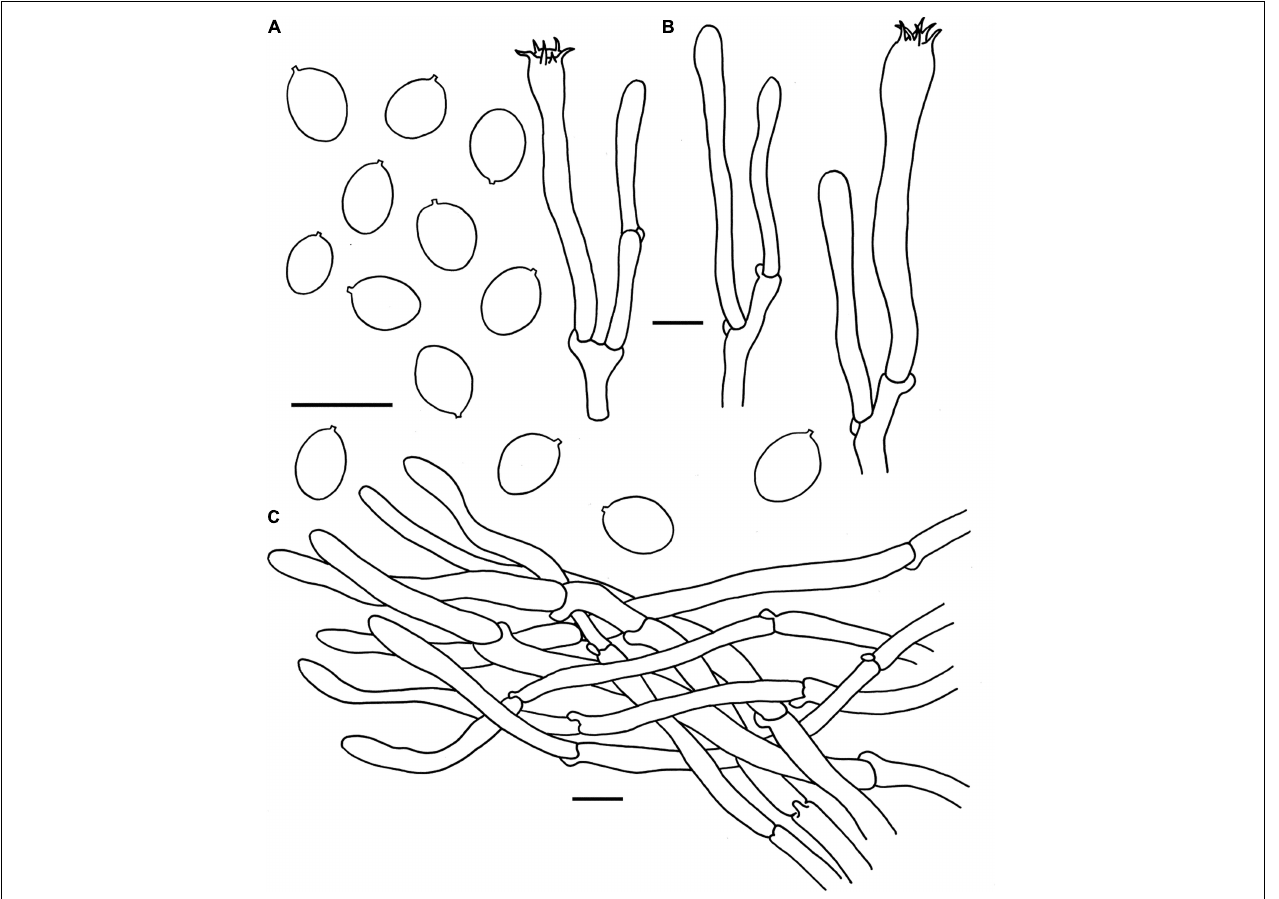
FIGURE 6 | Microscopic features of Cantharellus pinetorus (FHMU3759, holotype). (A) Basidiospores. (B) Basidia. (C) Pileipellis. Scale bars = 10 µ m. Drawings by Y. Z. Zhang.